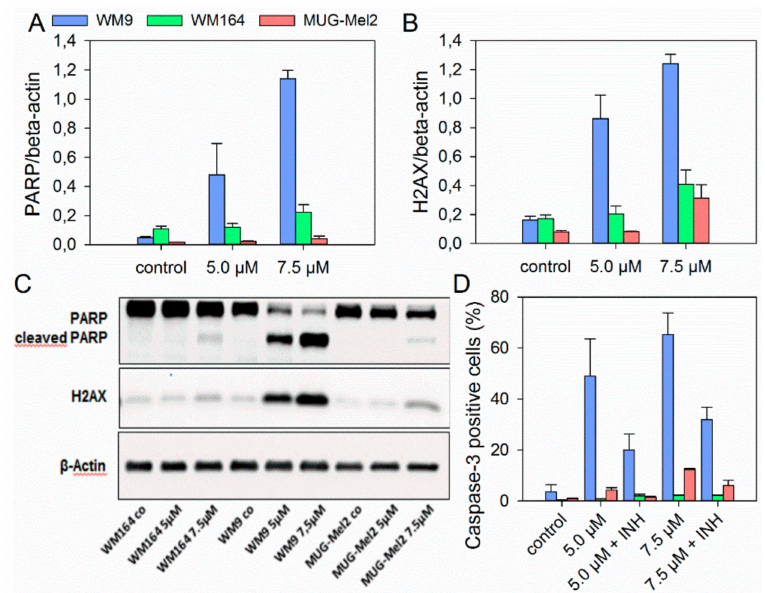
Figure 3. Western blot ( A – C ) and flow cytometric experiments ( D ) concerning apoptosis induction in different melanoma cells. ( A ) Densitometric analysis of the apoptotic marker cleaved PARP and ( B ) the DNA damage marker phosphorylated H2AX. The effect of 6 on three different melanoma cell lines was evaluated by immunoblotting under control conditions and in the presence of 5.0 µ M and 7.5 µ M of 6 for 24 h. Fold change is normalized to controls (mean ± SD, n = 3). ( C ) One representative immunoblot out of three is shown. β -Actin was used as loading control. ( D ) Results of cleaved caspase 3 FACS measurements after treatment with 6 (5.0 and 7.5 µ M) and 24 h incubation with or without caspase 3 inhibitor (INH), which confirmed the results above (mean ± SEM, n = 6).